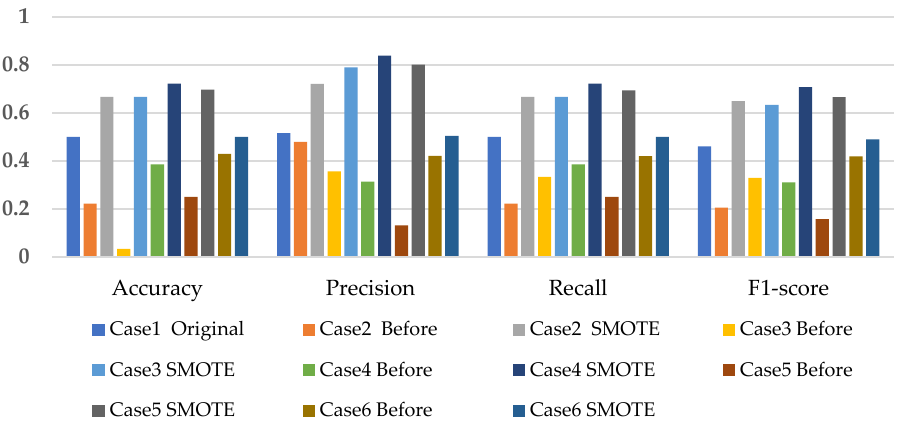
Figure 5. Simulation performance of NBC classification with SMOTE.